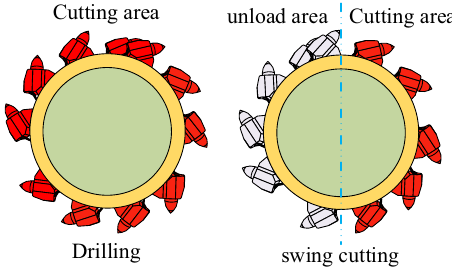
Figure 4. Relationship between cutting depth and number of cutting